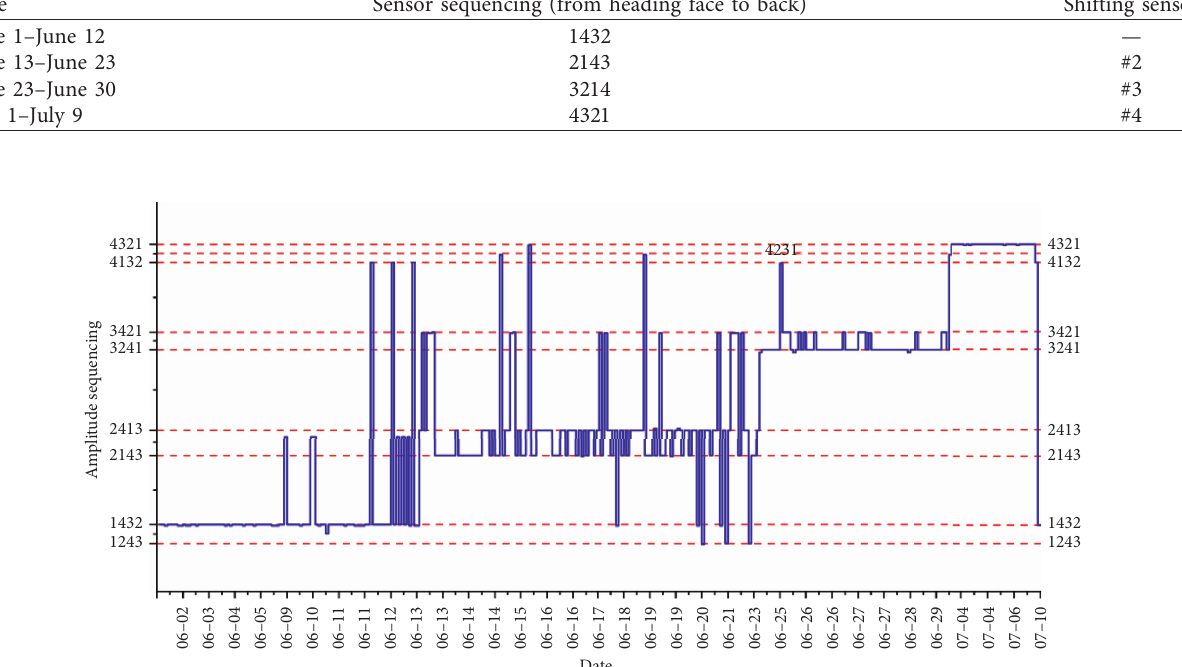
Figure 4: Amplitude sequencing of sensors in statistical